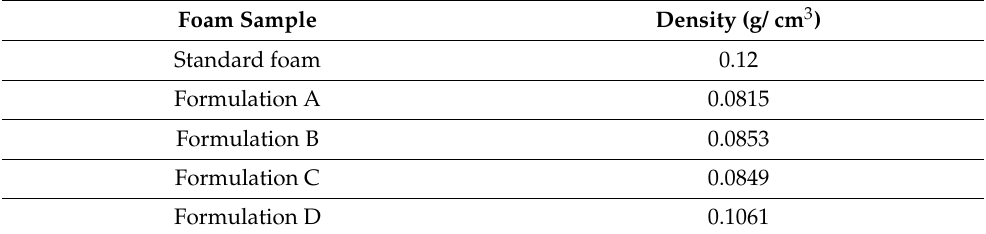
Table 5. Density of tannin foams with oil-grafted tannin. Foam